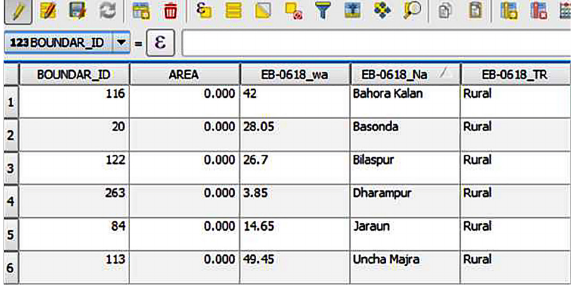
Fig. 7. Missing values in important